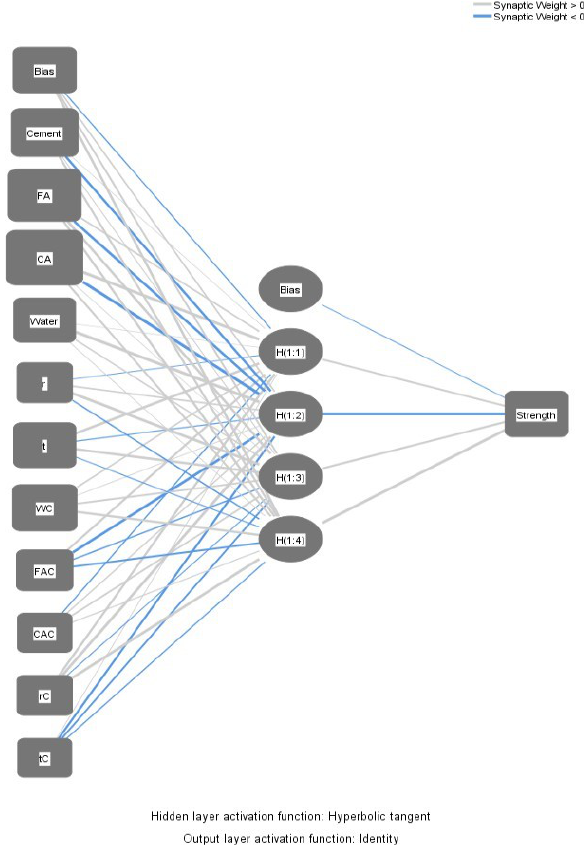
Figure 6: Neural Network [14]